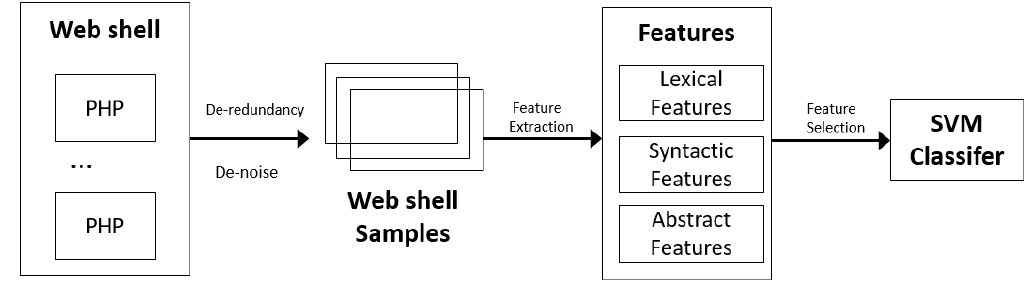
Figure 1. The overview of our method.